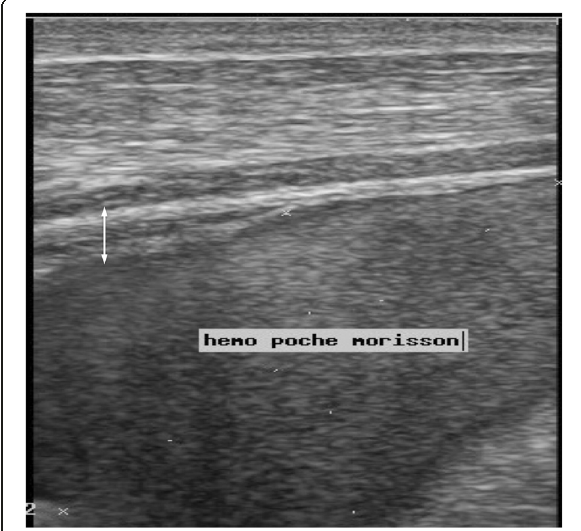
Fig. 5 Ultrasound image of a hemoperitoneum in the pouch of Morrison with echogenic appearance of parietal peritoneum thickening (double-headed arrow)